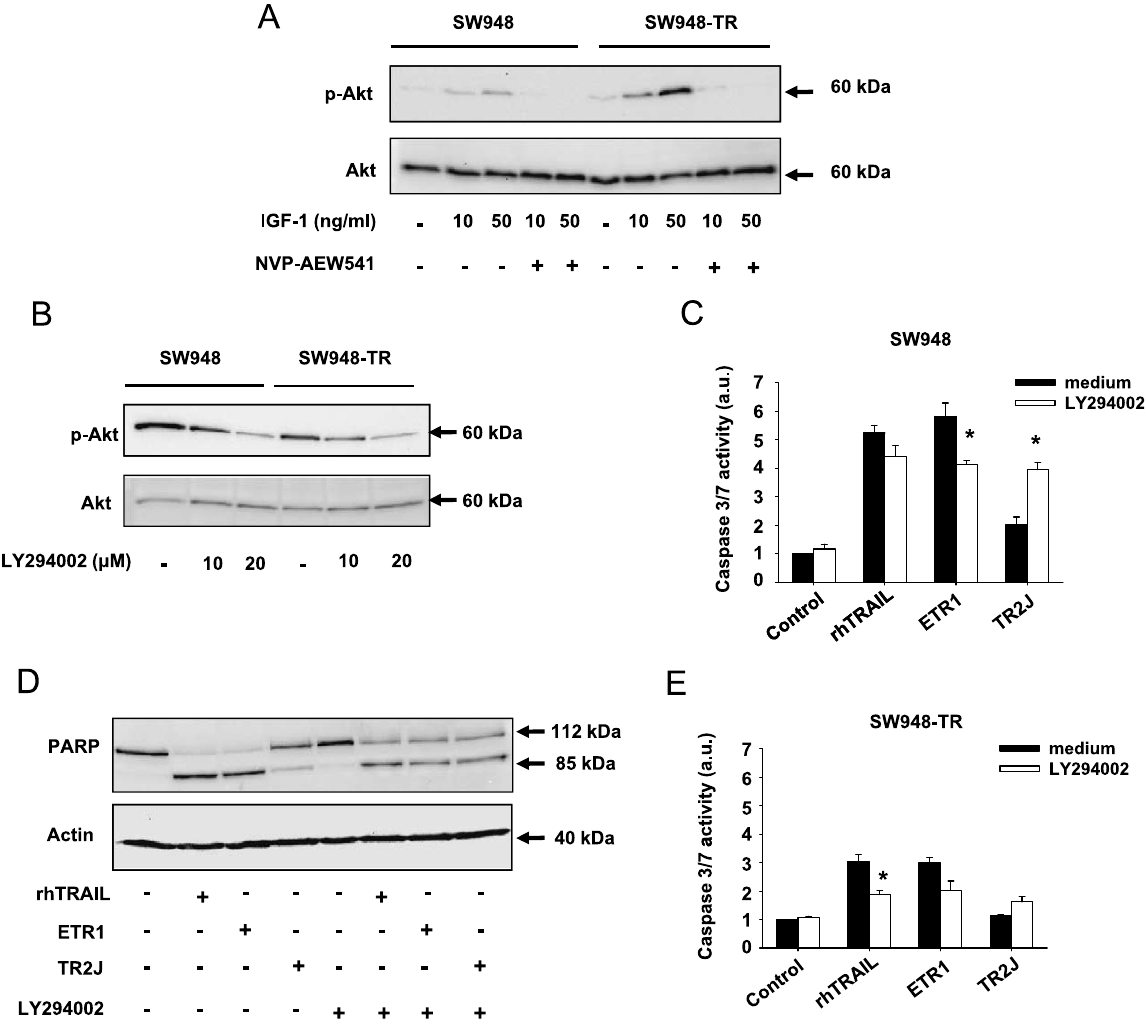
Fig. 3. PI3K mediates the effects of IGF-1R inhibition on DR-mediated apoptosis. (A) Western blot analysis showing inhibition of IGF-1-induced Akt phosphorylation by NVP-AEW541 in SW948 and SW948-TR. Cells were pretreated for 1 h with 5 µM NVP-AEW541 before treatment with increasing concentrations of rhIGF-1 and subsequent harvesting. (B) Western blot analysis showing inhibition of Akt phosphorylation by LY294002 in SW948 and SW948-TR. Cells grown in medium with FCS were treated or not for 1 h with increasing concentrations of LY294002 before harvest. (C) Modulation of rhTRAIL or agonistic antibody induced apoptosis by PI3K inhibition in SW948, as assessed by caspase 3/7 activity assay in SW948. Cells were pre-incubated for 15–18 h with 20 µM LY294002, then either left untreated or exposed to rhTRAIL (0.1 µg/ml), HGS-ETR1 (50 nM) or HGS-TR2J (50 nM) for 3 additional hours before harvest. (C) Caspase 3/7 activity assay in SW948 cells. Cells were pre-incubated for 15–18 h with 20 µM LY294002, then either left untreated or exposed to rhTRAIL (0.1 µg/ml), HGS-ETR1 (50 nM) or HGS-TR2J (50 nM) for 3 additional hours before harvest. (D) Western blot analysis of PARP cleavage in SW948. The cells were pre-incubated for 15–18 h with 20 µM LY294002, then either left untreated or exposed for 3 additional hours with rhTRAIL (0.1